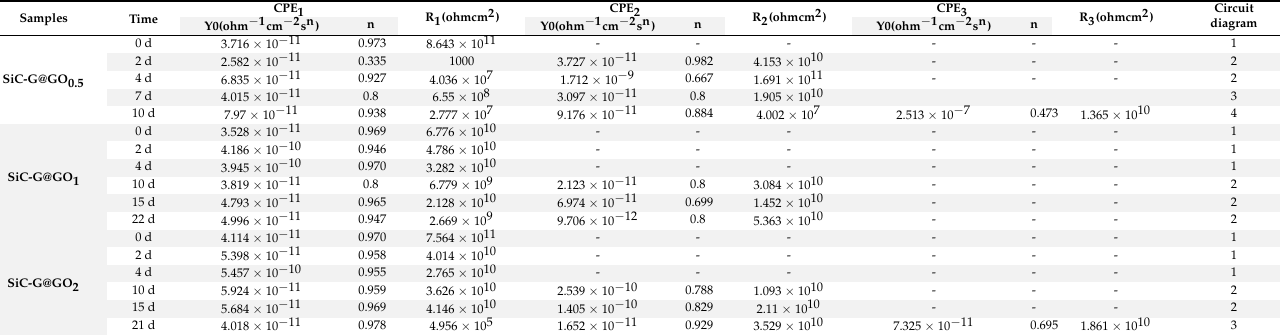
Table 3. EIS data of the SiC-G@GO nanocomposite coatings with different ratios.